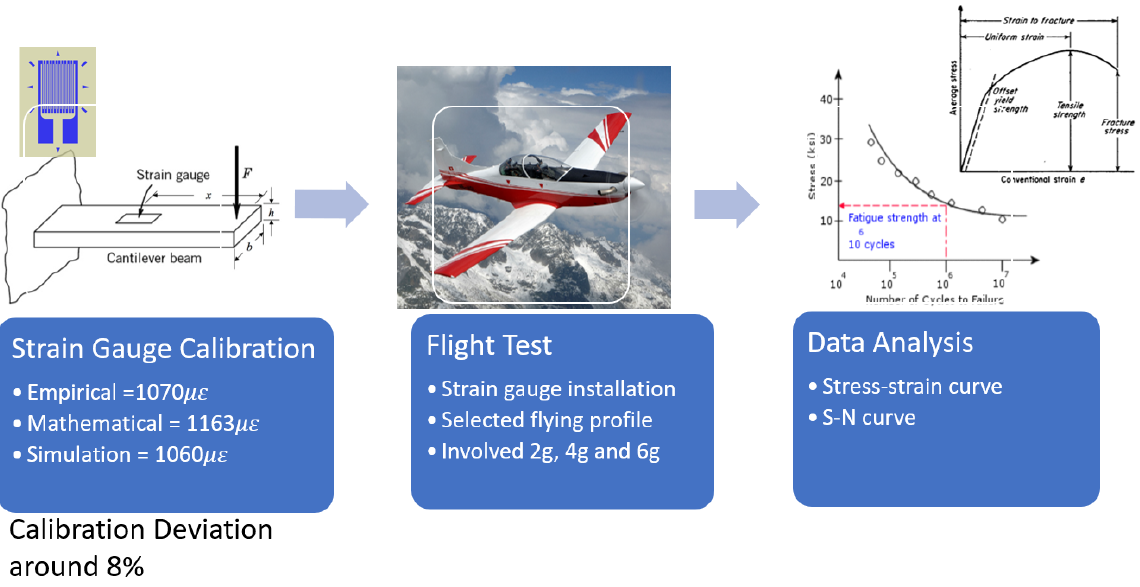
Figure 17. Data Gathering Process